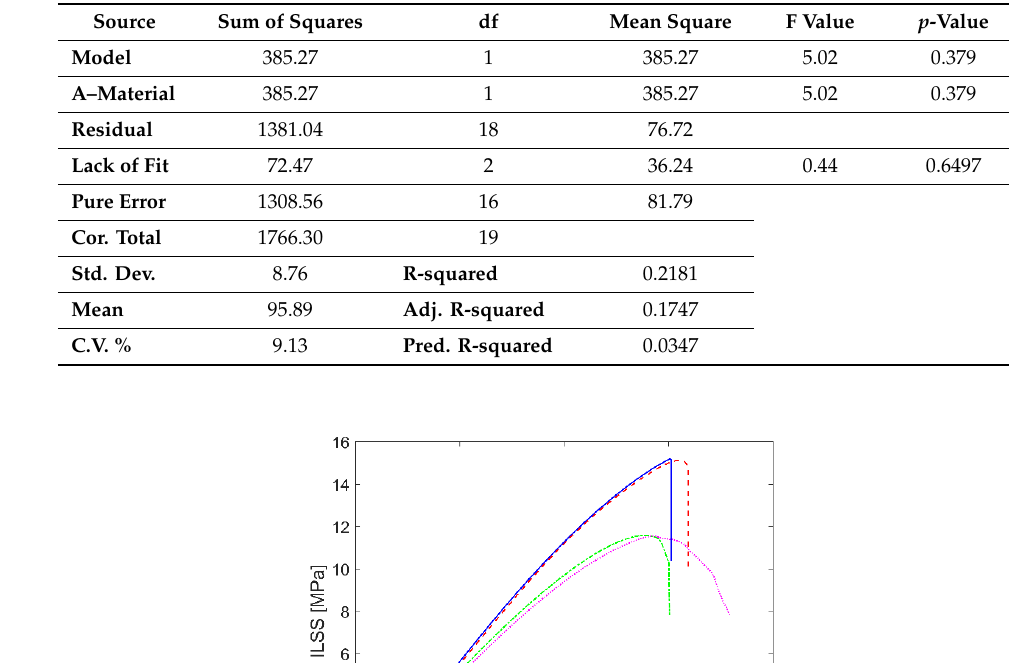
Figure 10. Average flexural stress versus displacement curves. Table 5. ANOVA table for flexural test (response: flexural strength).